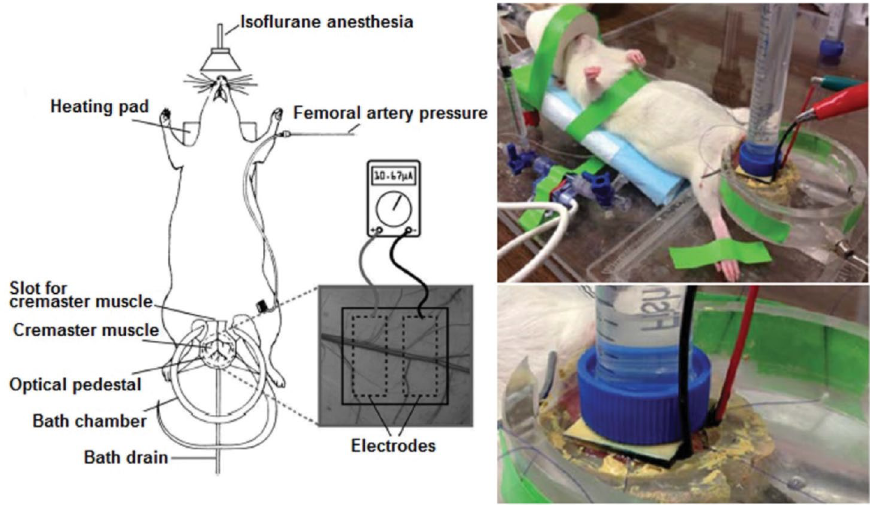
Fig. 19. Carbon nanotube-buckypaper based bioelectrodes deposited on the cremaster tissue of a rat [126]. Table 1. Comparison of the Electrical Outputs for Different Iplanted Enzymatic Biofuel Cells Operating in vivo a